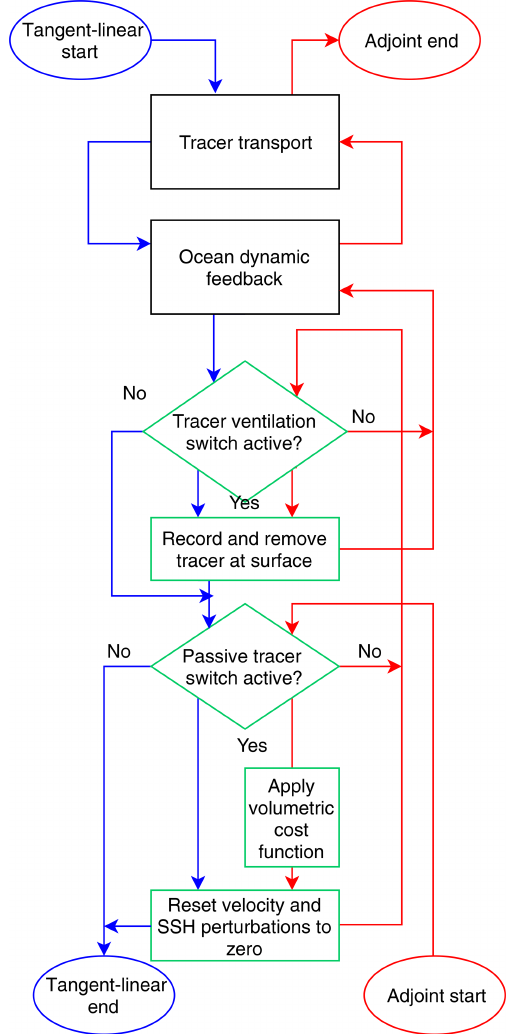
Figure 3. Adaptation of NEMOTAM time-stepping procedure for the tangent-linear (blue) and adjoint (red) cases. Steps outlined in green are new additions to the scheme.